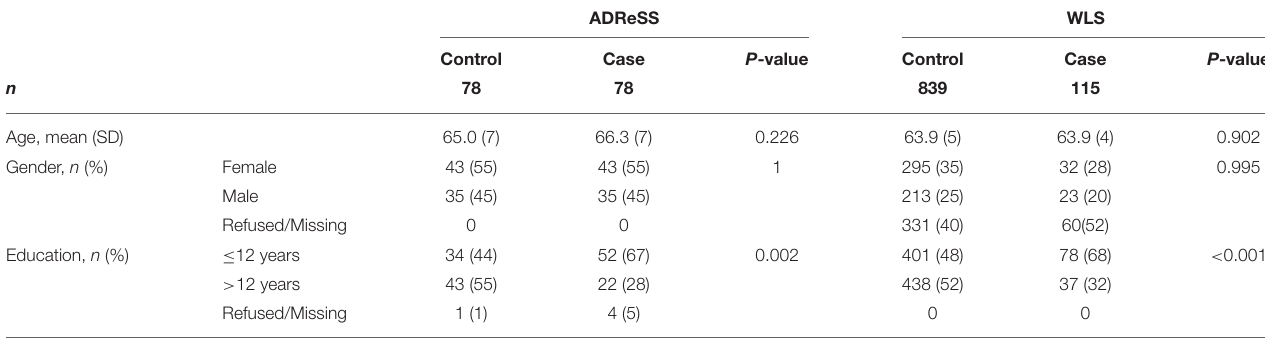
TABLE 1 | Dataset